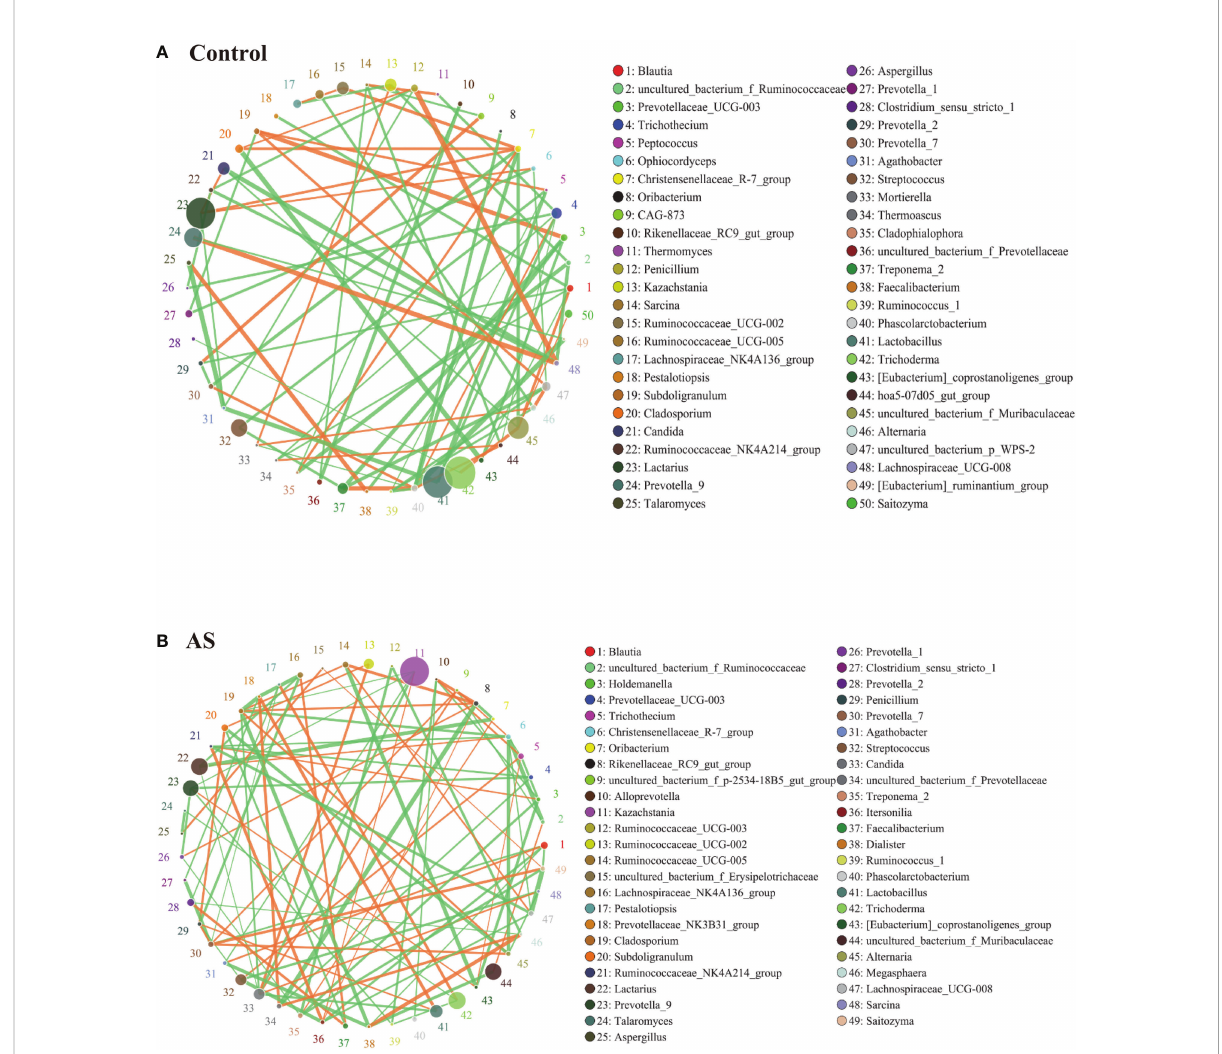
FIGURE 3 Bacterial – fungal association analysis in the AS and health monkeys. Note: Network graph is a form of correlation analysis. A Spearman rank correlation analysis was conducted according to the abundance and change of each species in each sample, and the data with correlations greater than 0.1 and P< 0.05 were screened to construct a correlation network. Based on network graph analysis, the coexistence relationship of species in environmental samples can be obtained, as can the interaction situation and important pattern information of species in the same environment, and the formation mechanism of phenotypic differences between samples can be further explained. (A) Correlation analysis of fecal microorganisms (fungi and bacteria) in healthy monkeys. (B) Correlation analysis of fecal microorganisms (fungi and bacteria) in AS monkeys. Note: The circle represents species, and the size of the circle represents the average abundance of species. The lines represent the correlation between two species, the thickness of the lines represents the strength of the correlation, and the color of the lines: orange represents a positive correlation and green represents a negative